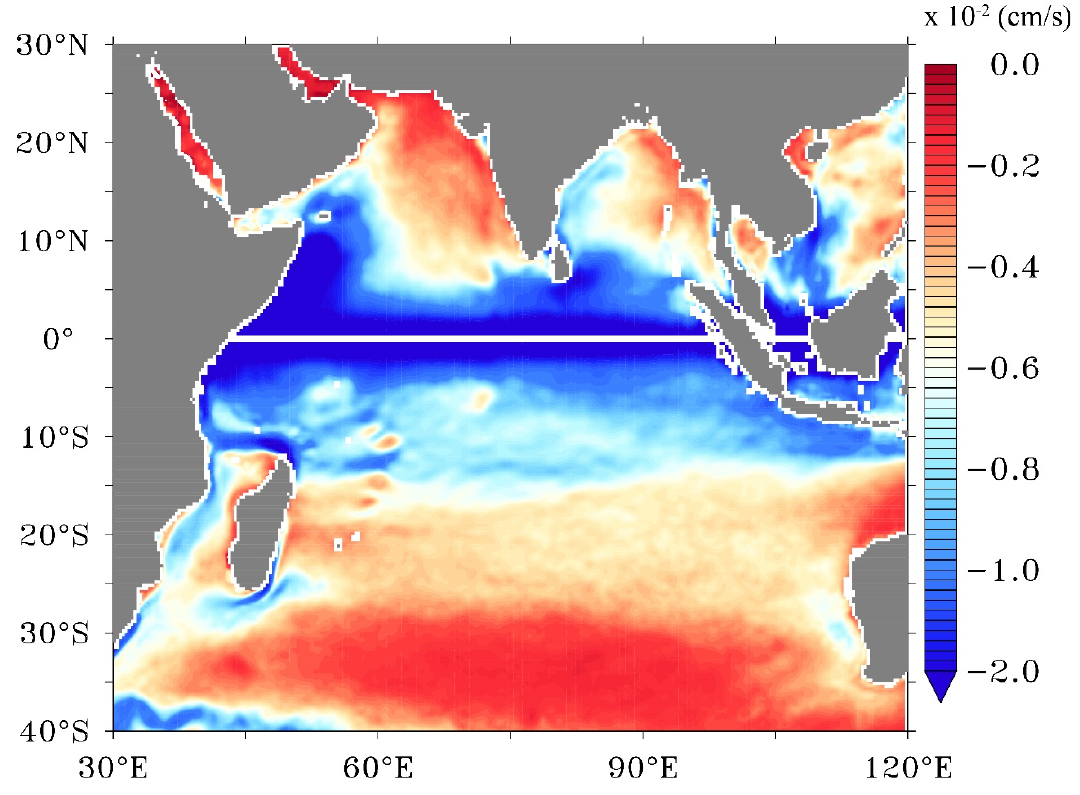
Figure 6. Average difference between the Ekman currents (cm/s) computed with and without the inclusion of currents in the wind stress during 2007–2020. Table 3. Basin wide area averages of Ekman currents and wind power input.